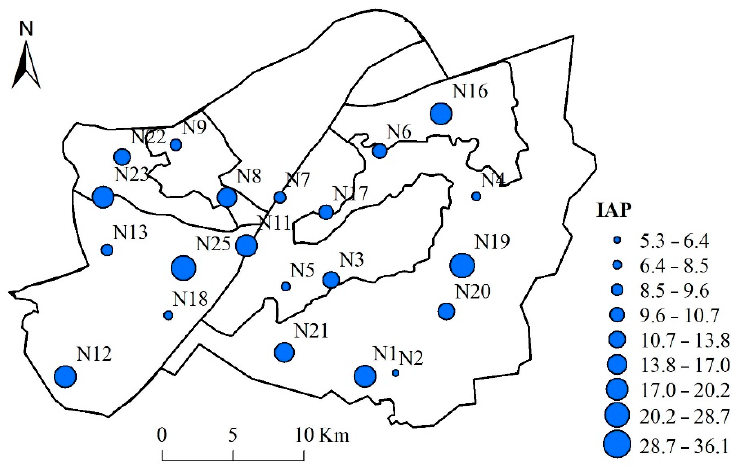
Figure 4. Spatial distribution of the index of atmospheric purity (IAP).